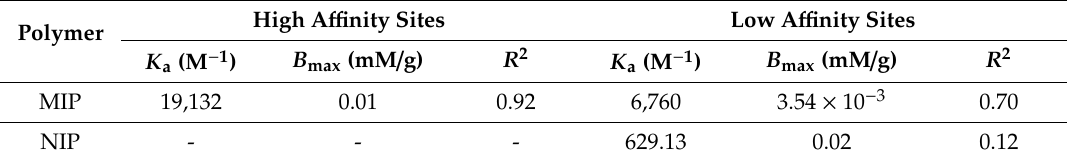
Figure 5. Scatchard analysis. Table 3. K a , B max , and R 2 values obtained by Scatchard analysis.